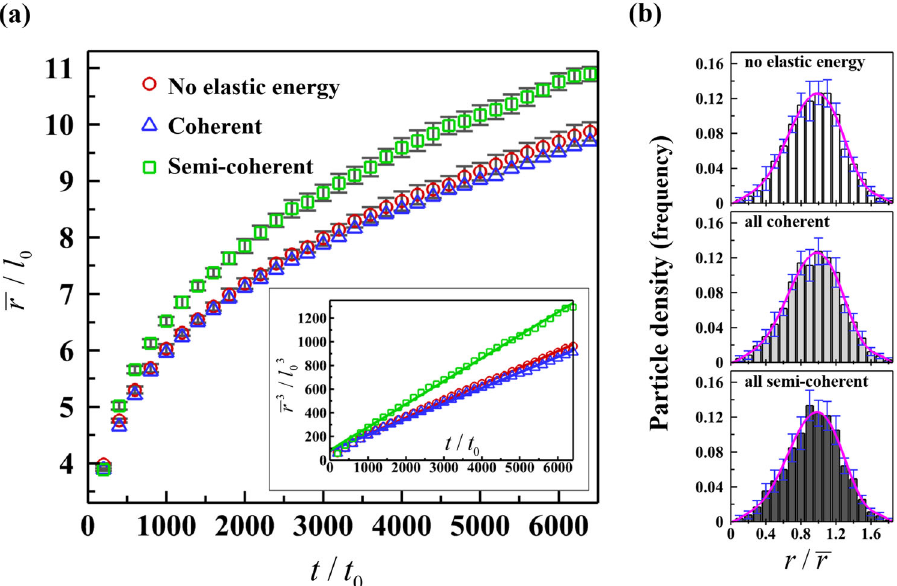
Fig. 3 Simulation of Ostwald ripening of precipitates. a Without elastic energy, with elastic energy and coherent interface, and with relieved elastic energy and semi-coherent interface. Each data point is the averaged value of the 10 simulations in each set and the error bar is set to the standard error of r = l 0 . b Particle size distribution in steady-state (at time 2500 t 0 ), where the solid magenta line is the fi tted PSD pro fi le from steady-state coarsening of all-coherent precipitates, and it is used as a reference in other situations as a reference. The error bar is set to the standard deviation of particle density in each bin over the 10 simulation